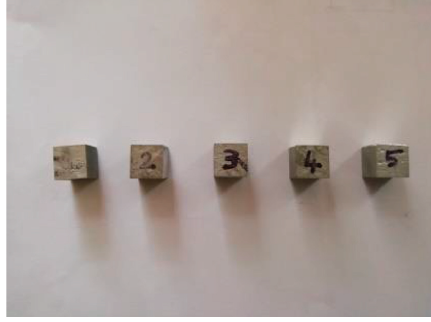
Figure 1: Test specimens for microstructural analysis.